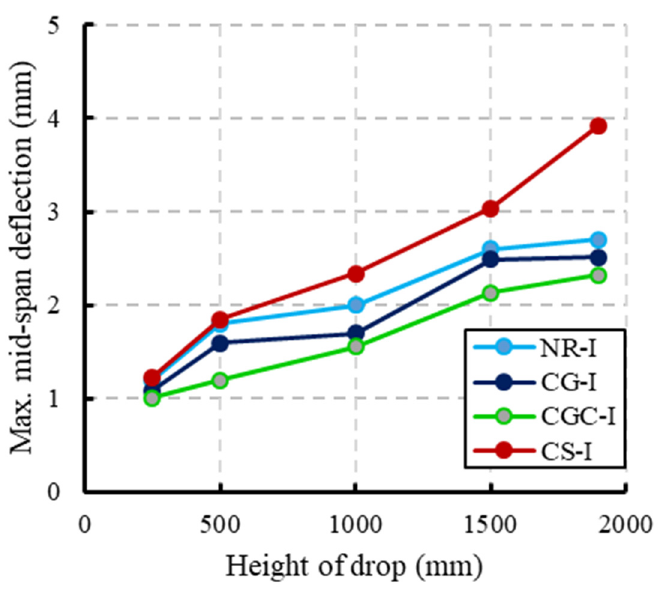
Figure 10. Comparisons of the maximum mid ‐ span deflection for different heights of drop.